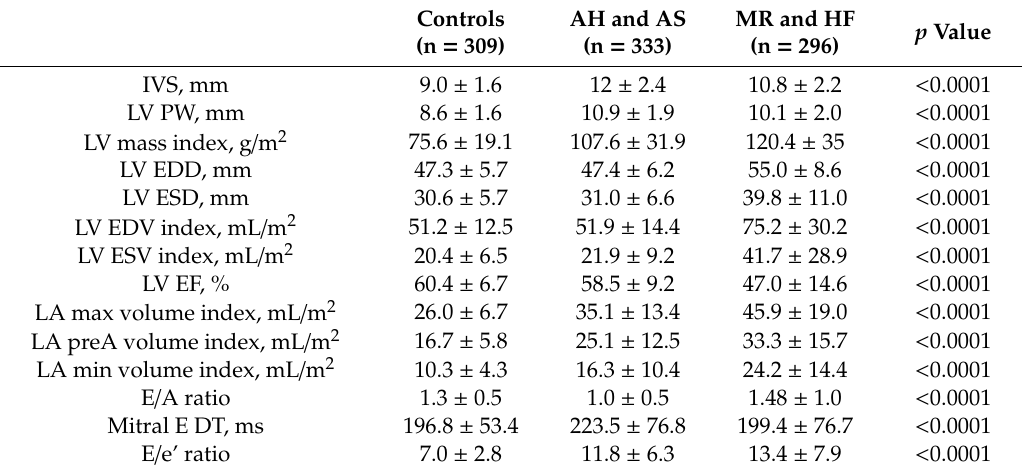
Table 2. Standard echocardiographic